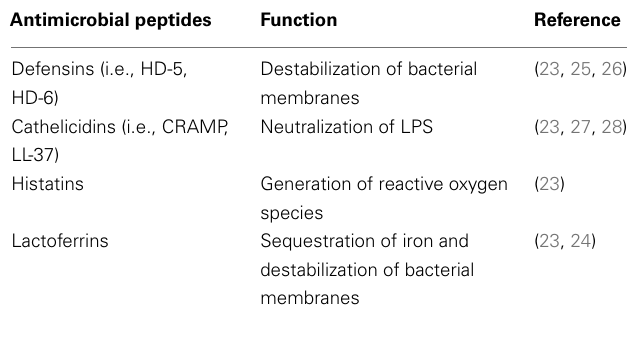
Table 1 | Summary of antimicrobial peptides